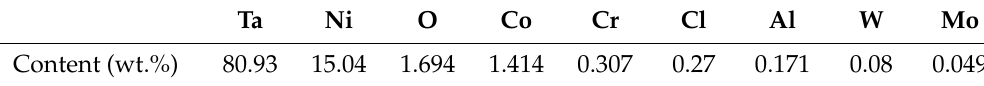
Table 4. EDS results of the corrosion products in the NaCl solution.